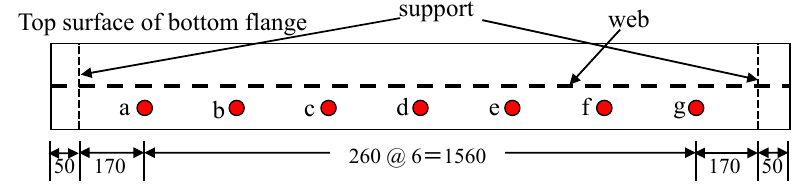
Figure 7. Vibration experiment in this study. Figure 8. Accelerometer installation position (unit: mm).